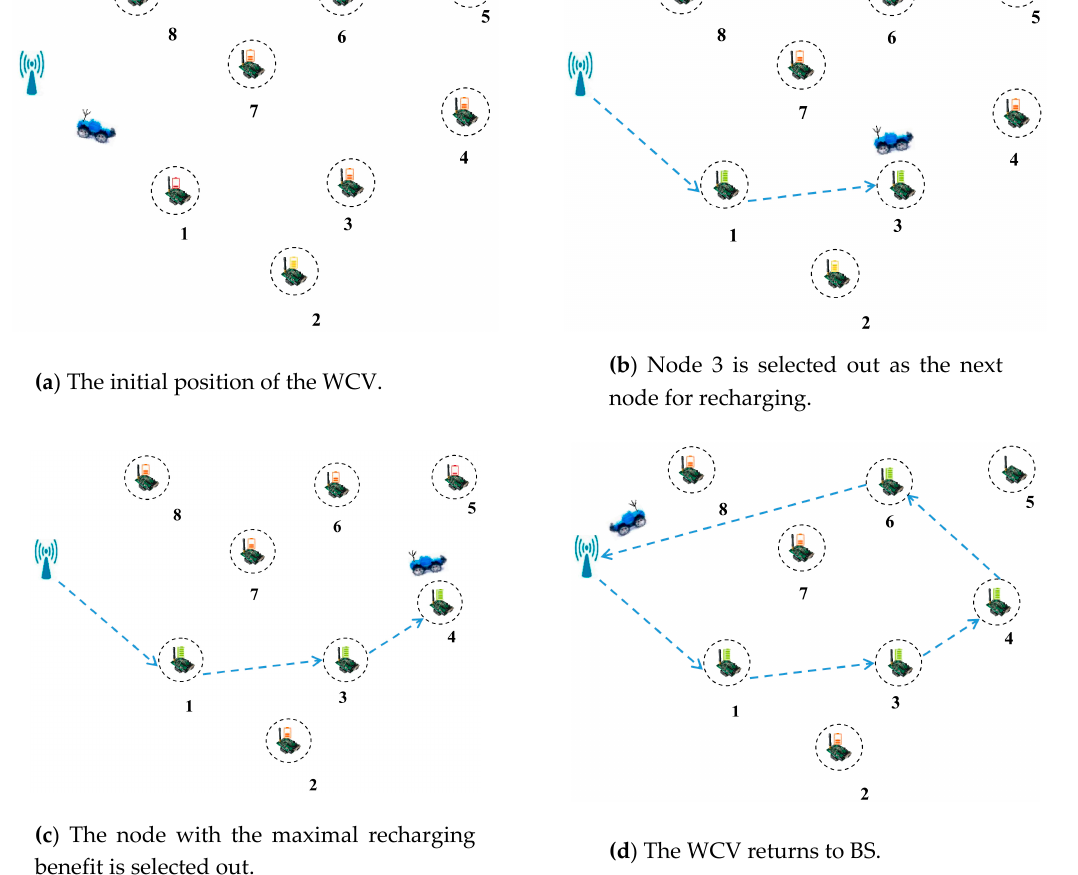
Figure 17. Wireless recharging scheme based on limited battery capacity and the maximum benefit.